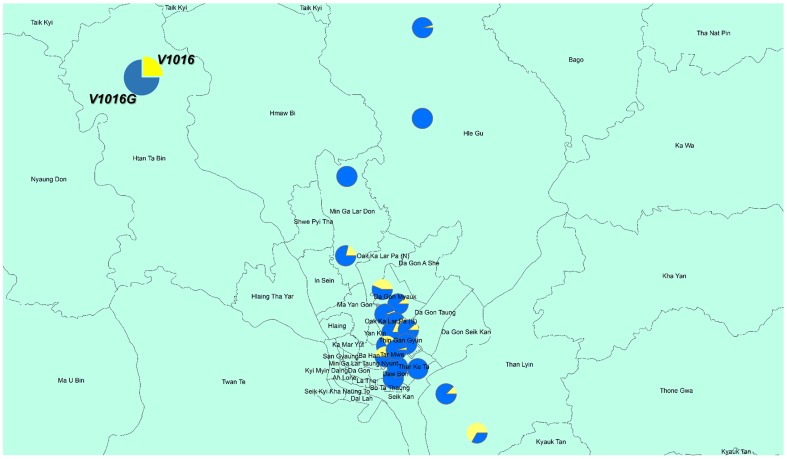
Distribution of the V1016G point mutation in Aedes aegypti larvae.The larvae were collected from used tires in Yangon City. Each circle indicates the allelic composition of the point mutations/wild types.